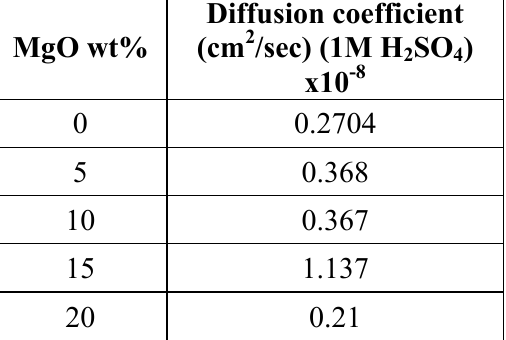
SO solutions. 2 4